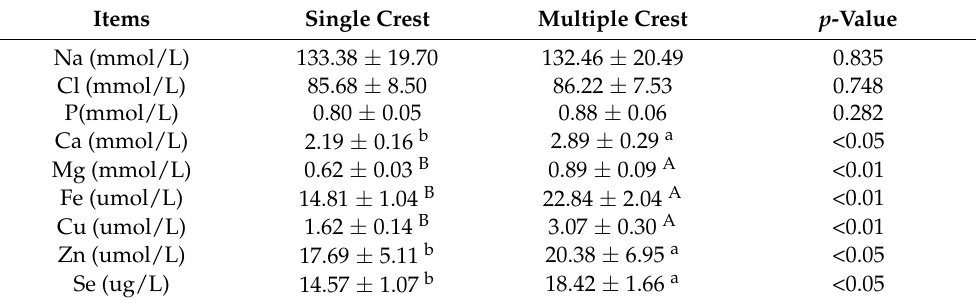
Table 4. Effect of crested-cushion number on trace elements in serum biochemical indexes.